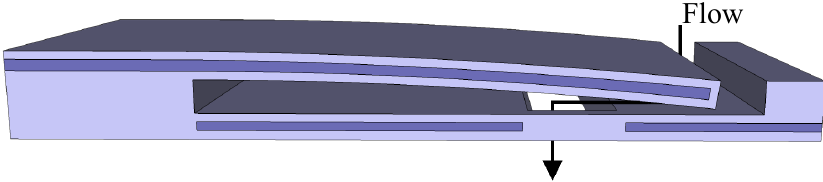
Figure 5. Electrostatic tilting plate microvalve [24].